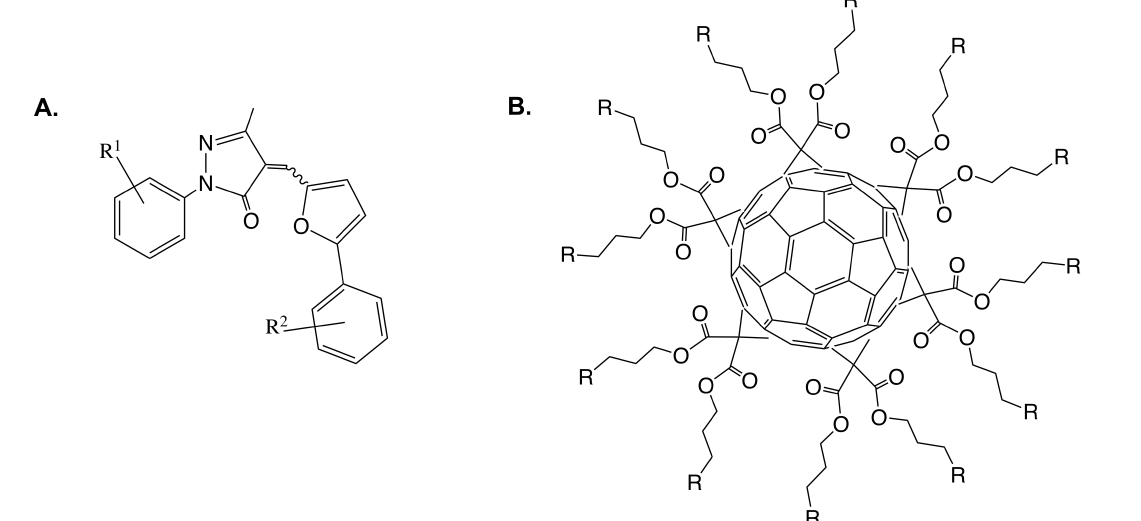
Figure 9. ( A ) Representative core structure of 2-aryl-5-methyl-4-(5-aryl-furan-2-yl-methylene)-2,4-dihydro- pyrazol-3-one analogues [58]; ( B ) Glycofullerene derivatives schematic